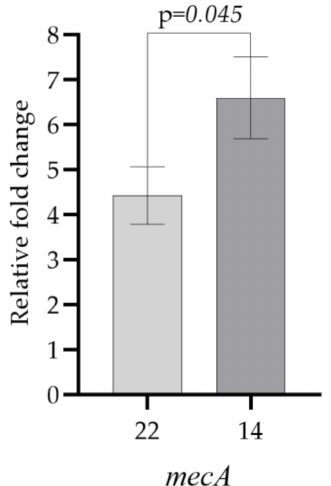
Figure 5. Comparison of mecA gene expression levels of test bacteria 14 and 22 , which developed resistance to oxacillin after 30 days of exposure to aluminum chlorohydrate, and the control group test bacteria taken on the first day as the starter (paired t -test).